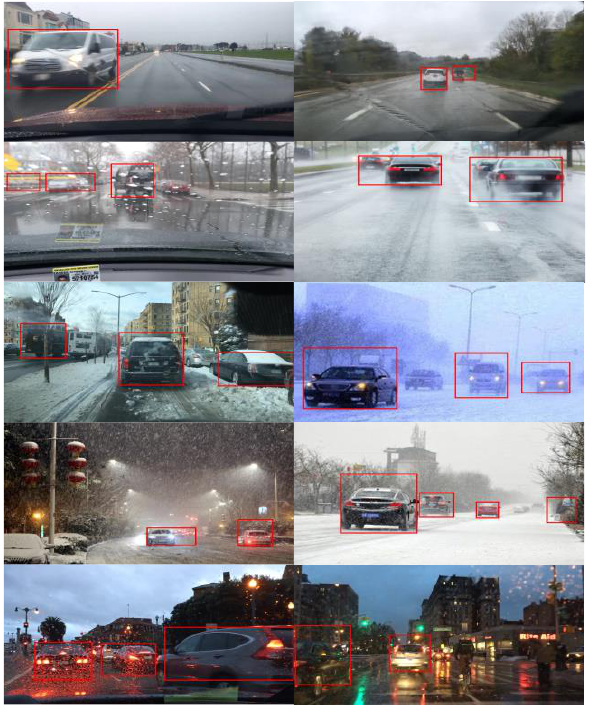
Figure 14. Detection results of complex environments. (rainy, snowy, and night with light interference).